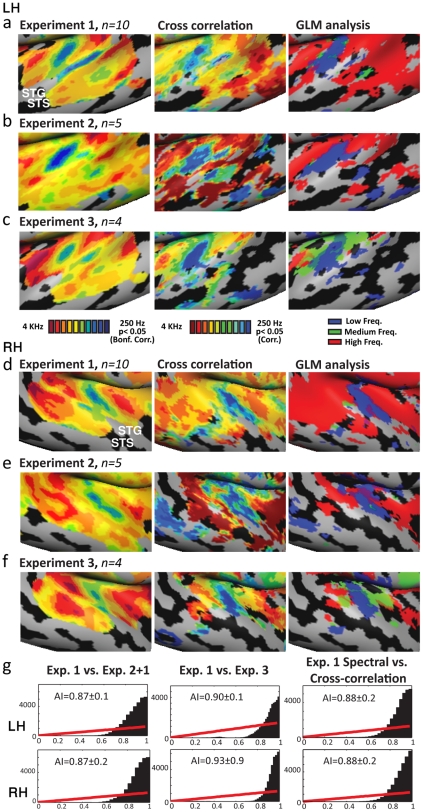
Consistency of the mirror-symmetric cochleotopic maps across experiments and analyses.
A. (left hemisphere) and D. (right hemisphere) display, on the left column, auditory cortex relative frequency preference map magnification as seen in
Figs. 2
 (LH) and 3 (RH), showing the mirror- symmetric cochleotopic maps inspected using spectral analysis. In the middle column cross-correlation analysis for the averaged single-subject time-course is displayed, showing remarkably similar trends to that of the spectral analysis. On the right column, the continuous auditory stimulation was analyzed by dividing it in a random effect general linear model (RFX-GLM) into low, medium and high frequency tone conditions. The GLM map displays the contrast of each frequency band with the other conditions. B. (left hemisphere) and E. (right hemisphere) display cross-correlation (middle) and GLM (right) analyses for Exp. 2 (n = 5) in which the chirp was reversed (i.e. from high to low frequencies). Spectral analysis (left) is the averaged phase map of Exp. 2 with Exp. 1, thus fully controlling for the hemodynamic delay of both experiments ([52], [53]; for the spectral maps of Exp. 2 alone see Fig. S5). The consistency of these results with the main experiment show that the auditory fields and cochleotopic gradients displayed for Exp. 1 do not result from the frequency modulation direction. C. (left hemisphere) and F. (right hemisphere) display spectral (left), cross-correlation (middle) and GLM (right) analyses for Exp. 3, in which a subgroup (n = 4) of subjects was scanned again one month after the original scan, revealing similar patterns of iso-frequency bands as the original (first scan) map, demonstrating the high test-retest reliability of the auditory fields and their locations. See also Fig. S8 for further single subject analysis of this experiment. G. Similarity alignment histograms are presented for three main contrasts, between the main experiment (Exp. 1) and the two control experiments (Exps. 2 and 3) and between the spectral and cross-correlation analyses in Experiment 1, for both hemispheres. The distribution of each comparison's alignment indexes (between 0 and 1 in each comparison) show a sharp peak towards 1, demonstrating their significance, and differ significantly (p<0.00001 in all comparisons presented) from random maps indexes (marked on the histograms with red line for comparison). Therefore, the similarity indexes of the correspondence between the relative frequency preference maps across analyses and experiments support the high replicability of the cochleotopic maps.